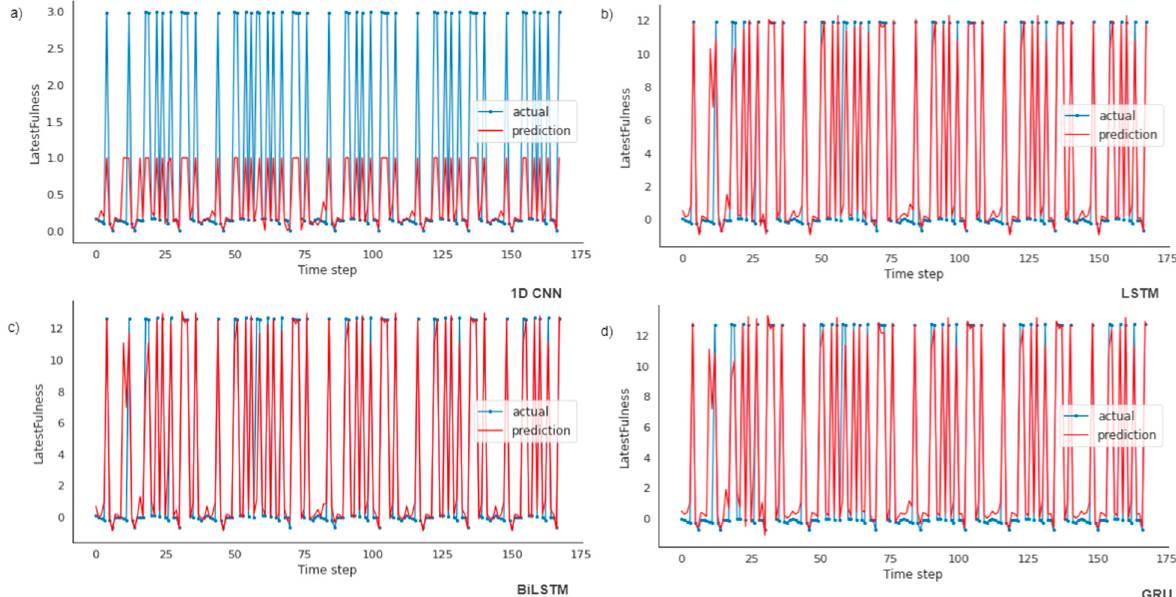
Figure 7. Actual and predicted bin fullness using four models: ( a ) Plot of actual vs. predicted values for 1D CNN model; ( b ) Plot of actual vs. predicted values for LSTM model; ( c ) Plot of actual vs. predicted values for BiLSTM model; ( d ) Plot of actual vs. predicted values for GRU model.